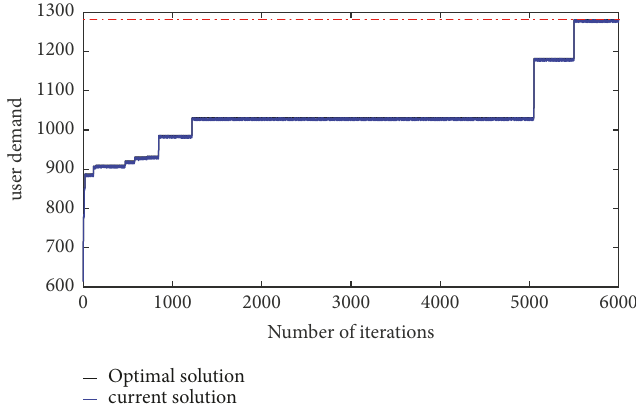
Figure 7: Diagram of algorithm convergence of Figure 6(a) of virtual station.